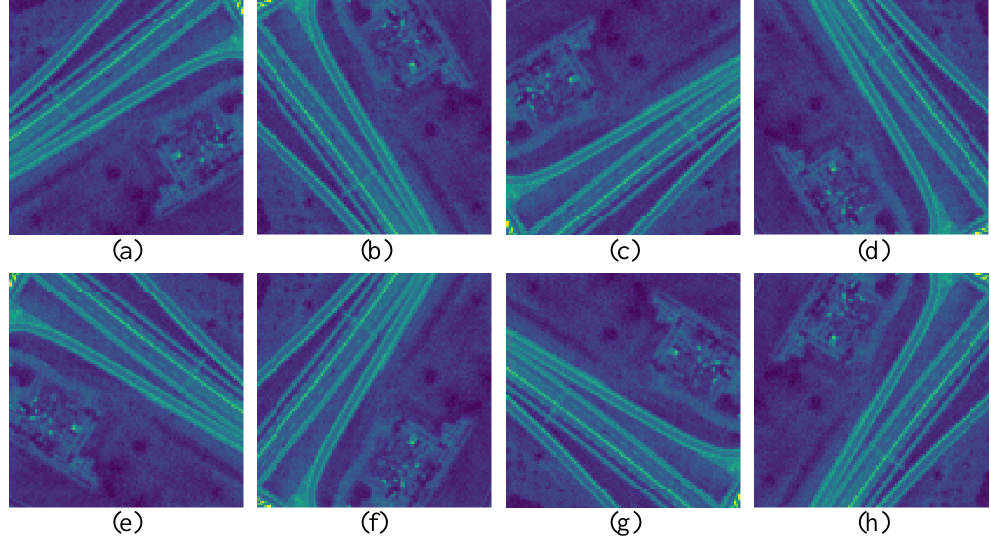
Figure 4. The example of data augmentation. ( a ) the original image; ( b – d ) the images after rotation of 90, 180, and 270 degrees anticlockwise; ( e ) vertical flip of ( c ); ( f ) horizontal flip of ( d ); ( g – h ) the horizontally and vertically flipped images of ( c , d